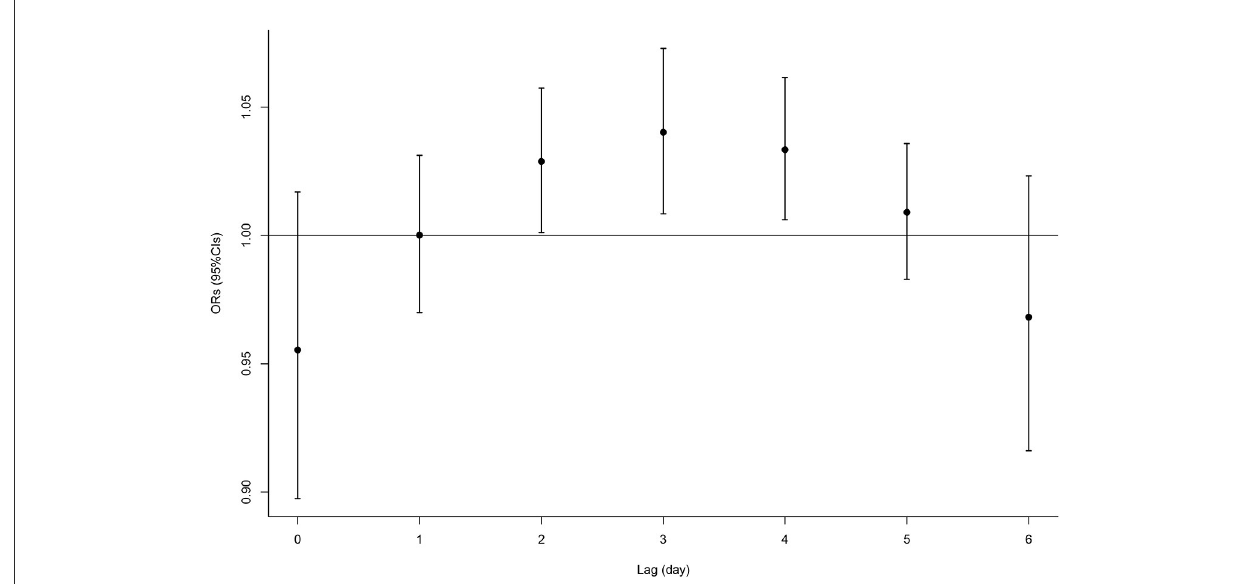
FIGURE1 The OR value in occurrence of fracture associated with O 3 at different lag periods.